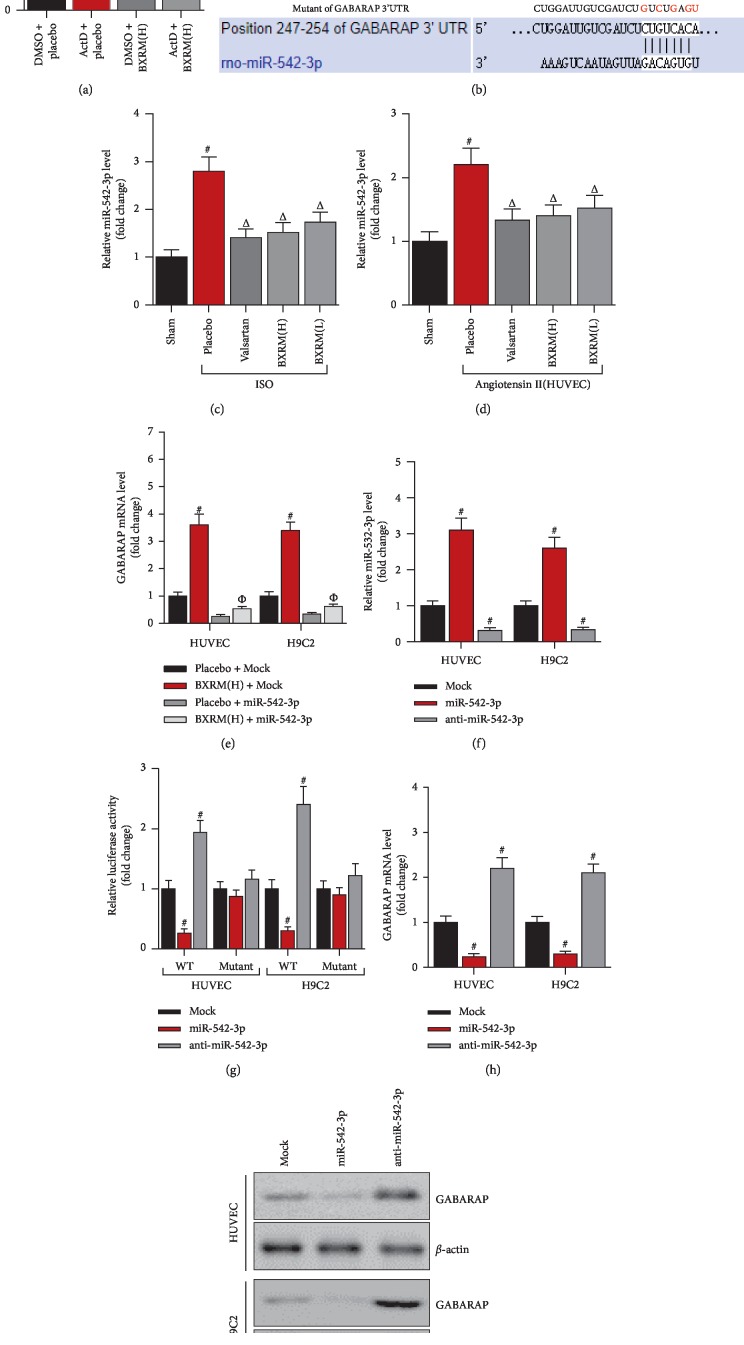
miR-542-3p is involved in Granule of BU-XIN RUAN-MAI-induced upregulation of GABARAP expression. (a) Real-time PCR of GABARAP expression in HUVEC cells and the cells were incubated with both ActD and Granule of BU-XIN RUAN-MAI for 10 h; #P < 0.001 versus the DMSO + placebo and ΔP < 0.05 versus DMSO + Granule of BU-XIN RUAN-MAI. (b) Predication of binding site of miR-542-3p on GABARAP 3′UTR by Targetscan (http://www.targetscan.org/vert_72/). (c) Real-time PCR analysis of miR-542-3p in rat heart after Granule of BU-XIN RUAN-MAI administration as described above; #P < 0.001 versus the sham and ΔP < 0.05 versus ISO + placebo. (d) Real-time PCR analysis of miR-542-3p in HUVEC after Granule of BU-XIN RUAN-MAI incubation; #P < 0.001 versus the sham and ΔP < 0.05 versus angiotensin II + placebo. (e) Real-time PCR analysis of GABARAP in HUVEC and H9C2 cells after transfection for 48 h followed by Granule of BU-XIN RUAN-MAI incubation for 24 h; #P < 0.001 versus placebo + Mock and ΔP < 0.05 versus placebo + miR-542-3p. (f) Real-time PCR analysis of GABARAP in HUVEC and H9C2 cells after transfection for 48 h; #P < 0.001 versus Mock. (g) Luciferase reporter assay analysis of pmir-GABARAP-3′UTR luciferase activity after transfection for 48 h; #P < 0.001 versus Mock. (h) Real-time PCR analysis of GABARAP expression after transfection for 48 h, #P < 0.001 versus Mock. (i) Western blot analysis of GABARAP expression after transfection for 48 h. The data are representative of three independent experiments.